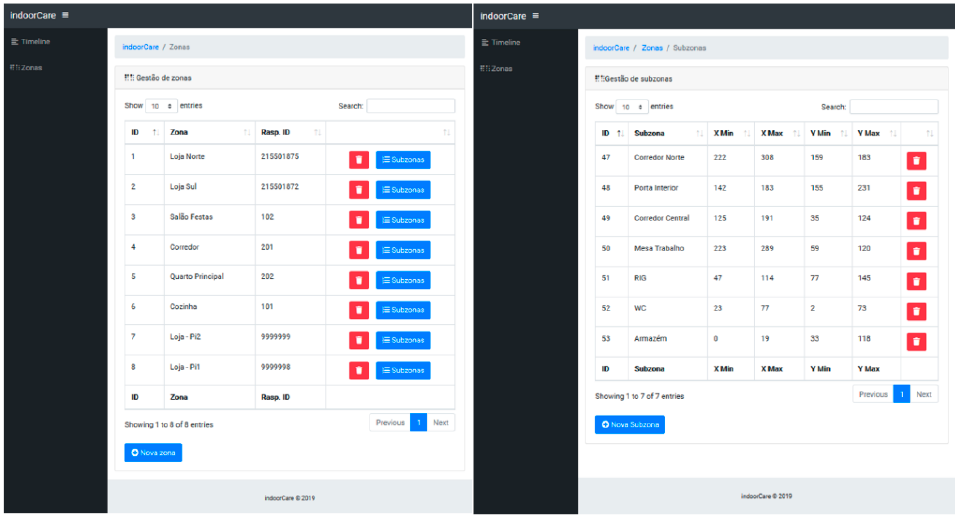
Figure 9. Management of zones and subzones.